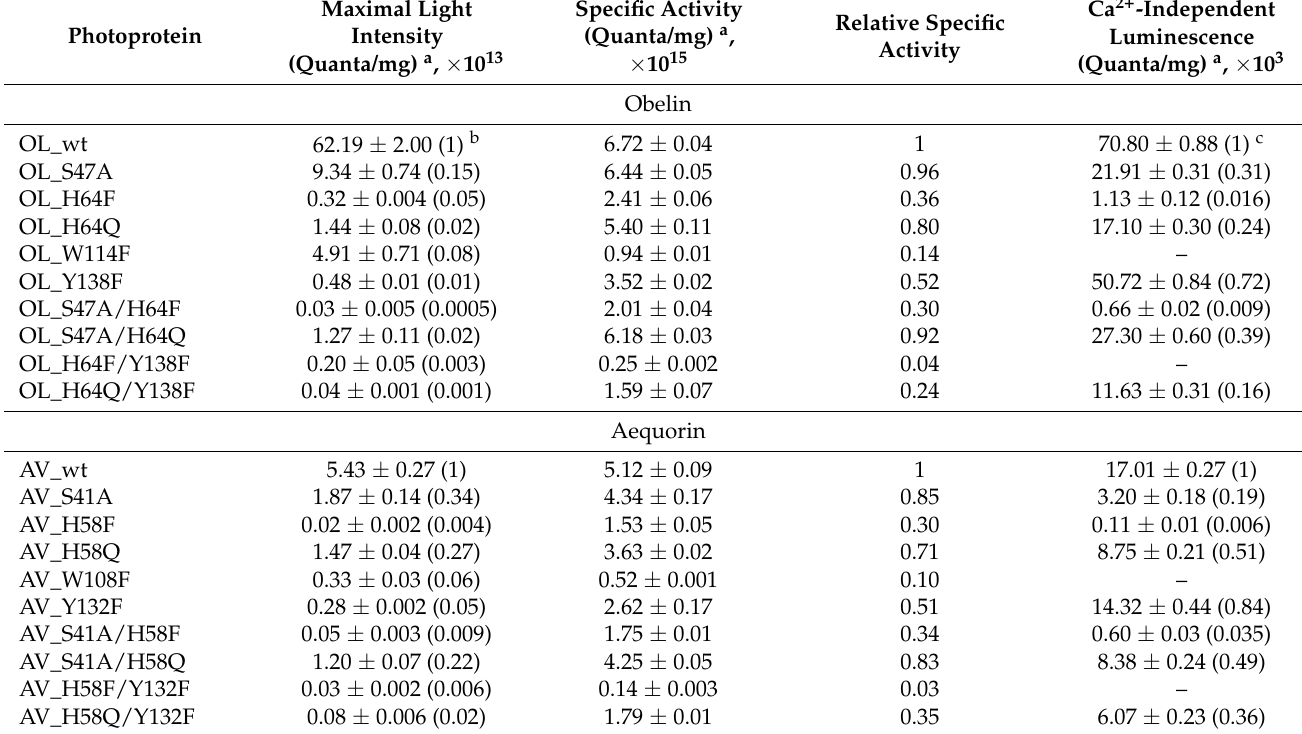
Table 1. Bioluminescence properties of obelin and aequorin